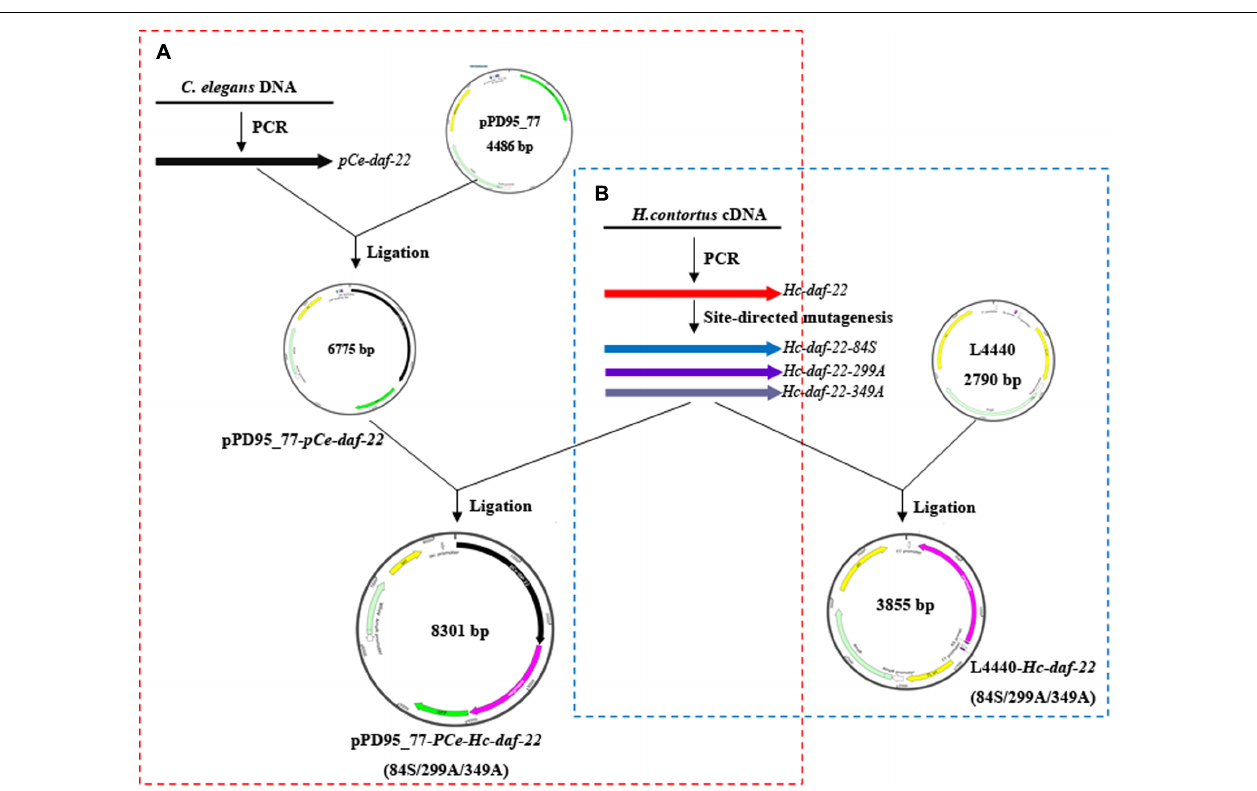
FIGURE 2 | Construction of recombinant plasmids used in rescue and RNAi experiments. (A) Cloning Hc-daf-22 and three mutants into pPD95_77 with Ce-daf-22 promoter upstream. (B) Cloning Hc-daf-22 and three mutants into